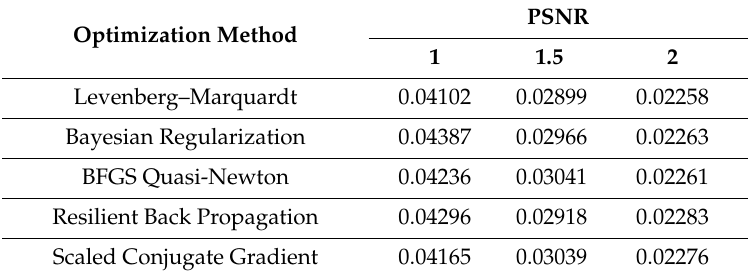
Table 1. The results of denoising, the factor RMSE, by five optimization methods and in the cases of three levels of noise (PSNR) including 1, 1.5, and 2.